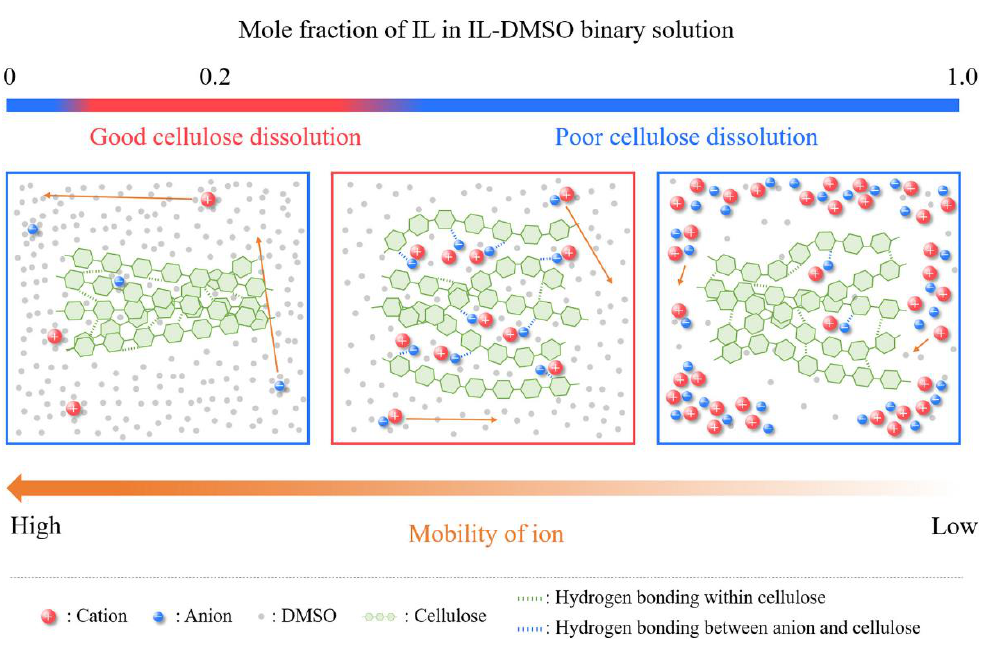
Figure 7. Schematic representation of the e ff ect of binary mixture composition on cellulose dissolution. The left part is at high IL dilution with DMSO, the central part is at χ IL ca. 0.2 where maximum microcrystalline cellulose (MCC) dissolution occurs. Further dilution with the molecular solvent (MS) results in sharp decrease of cellulose solubility. Representation based on conductivity and solvatochromic data, reproduced form [71], with permission from Elsevier2019.